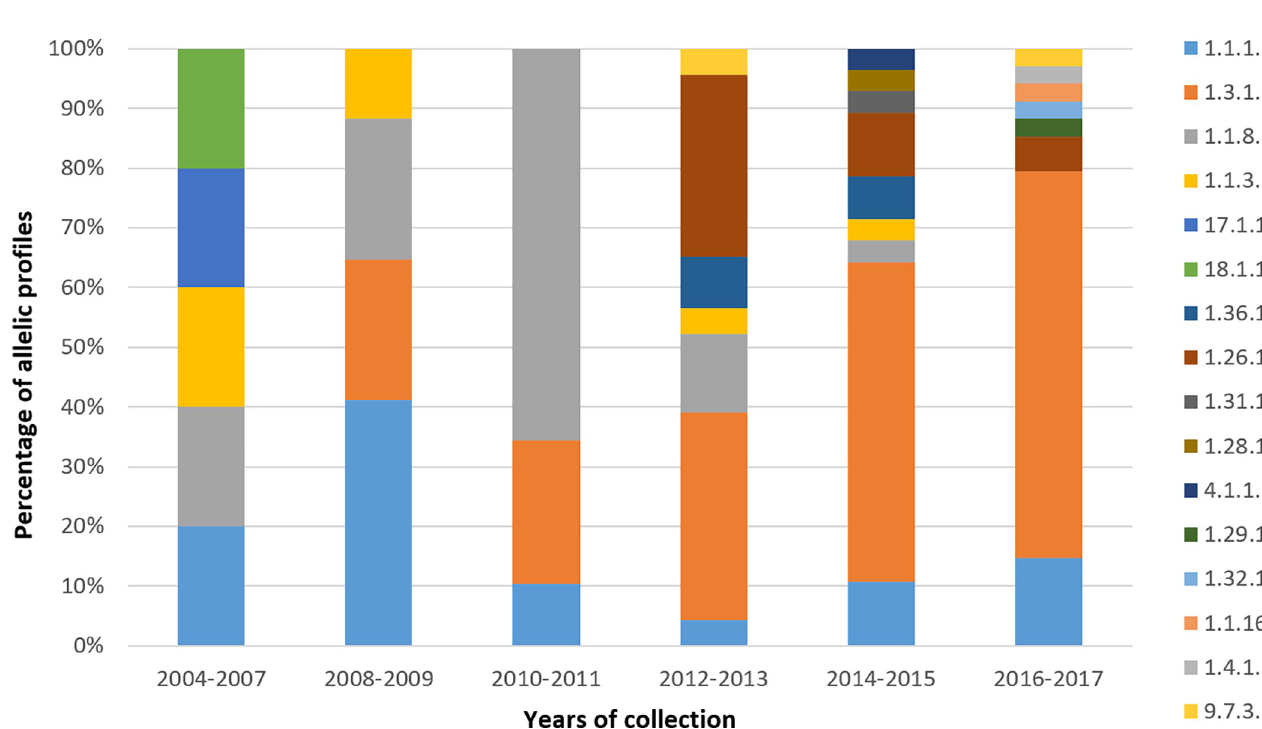
Fig 3. Distribution of TPA allelic profiles identified in the Czech Republic from 2004 to 2017.